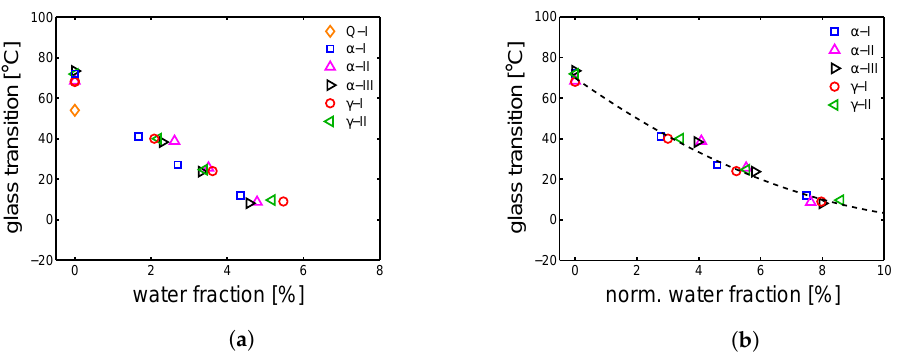
Figure 12. ( a ) glass transition temperatures (obtained by DMTA) as functions of the water fraction absorbed by the samples; ( b ) glass transition temperatures as functions of the normalized water fractions (line is a guide to the eye).